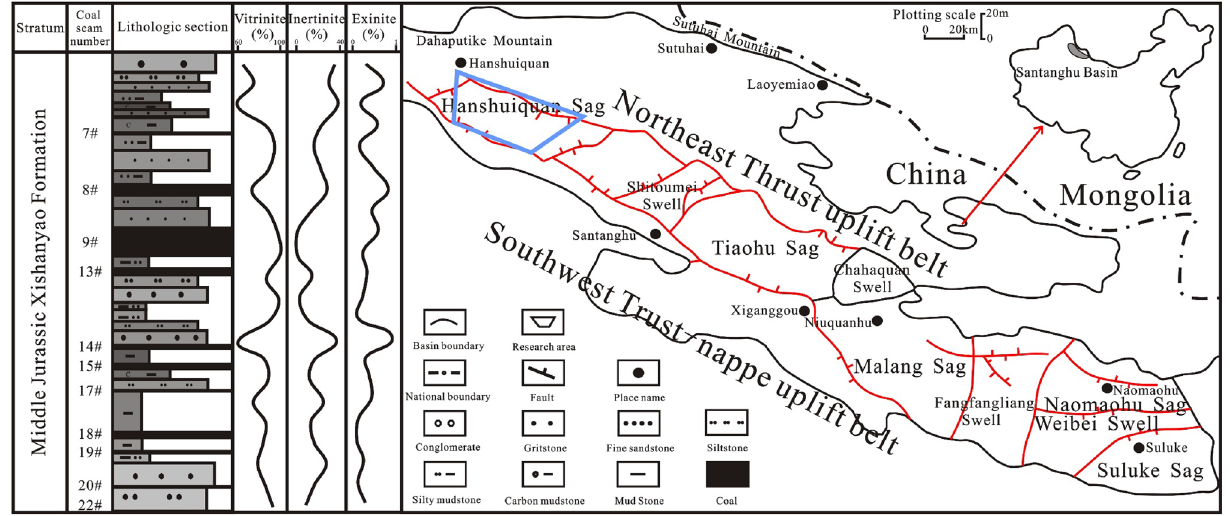
Fig. 1 The research area location, the lithotype distribution and the change tendency of samples macerals in Xishanyao Formation, Hanshuiquan district, Santanghu Coalfield, NW